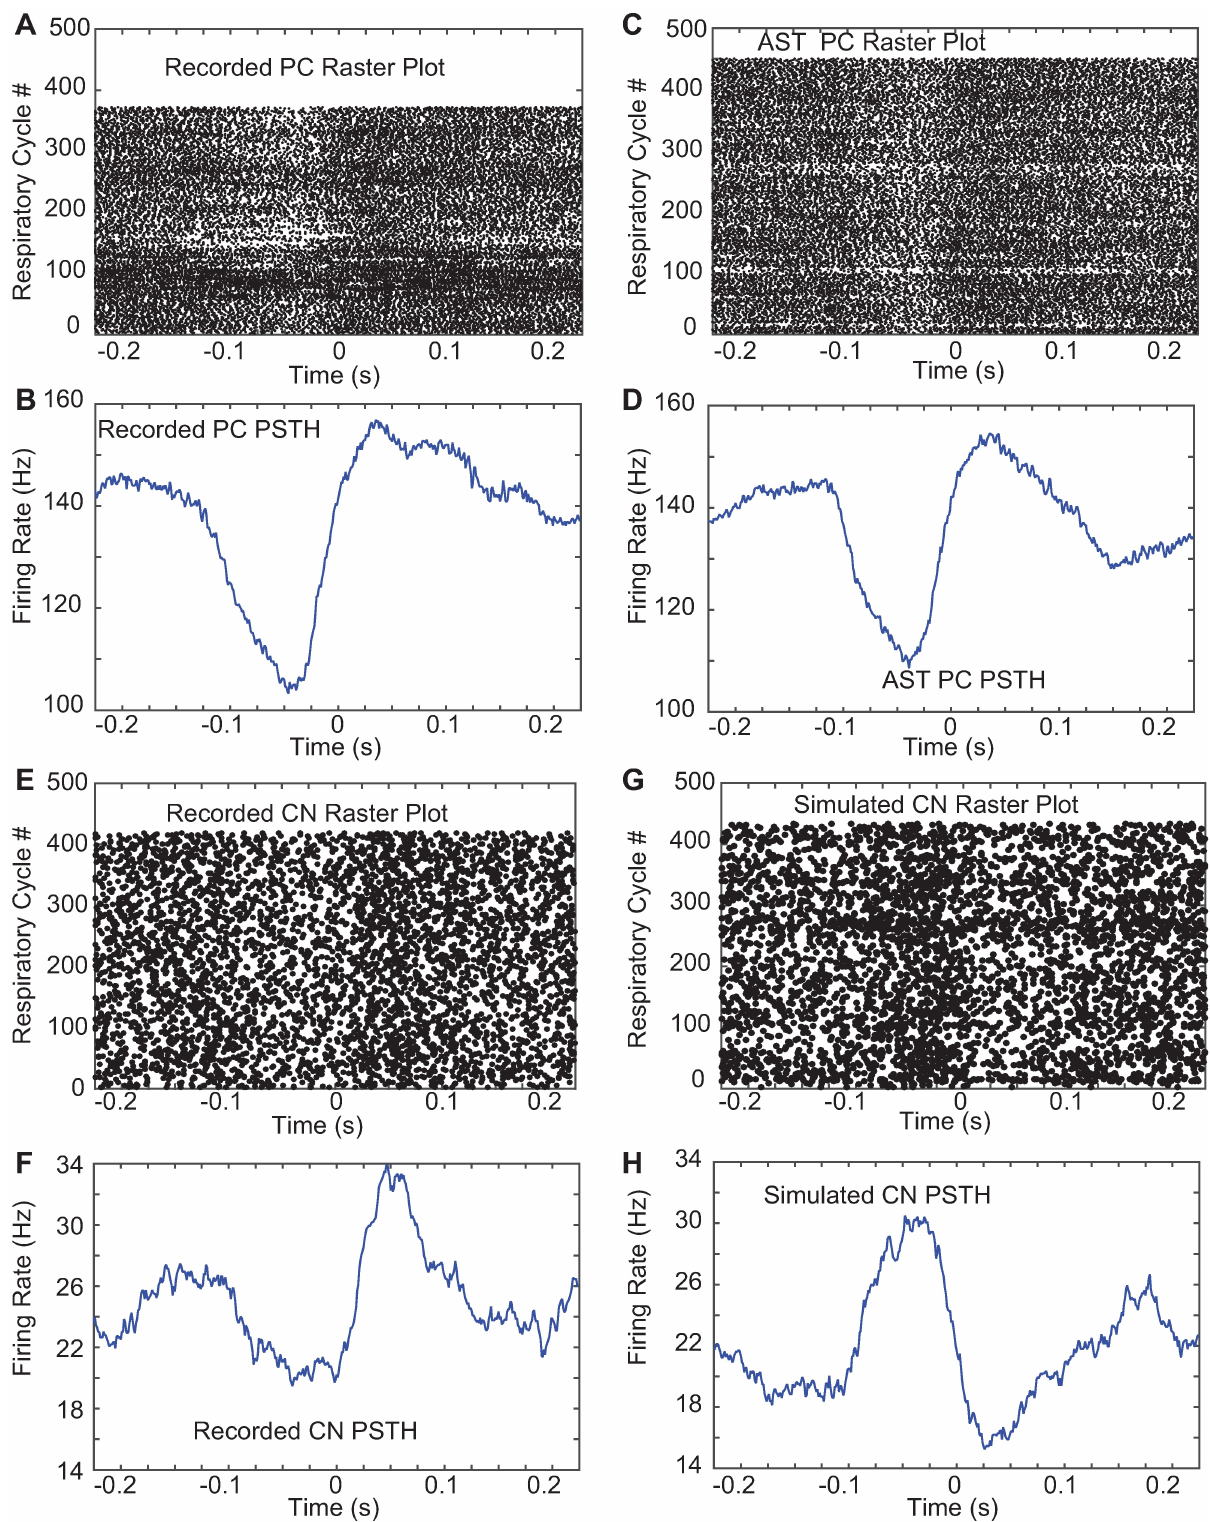
Fig 5. Recorded and simulated peri-stimulus time histograms (PSTH) for respiration. The medianrespiratory intervalin our data set was 242 ms (respiratoryfrequencyof 3.9 Hz), therefore approximately one full respiratory cycle is shown to each side of the event trigger. A,